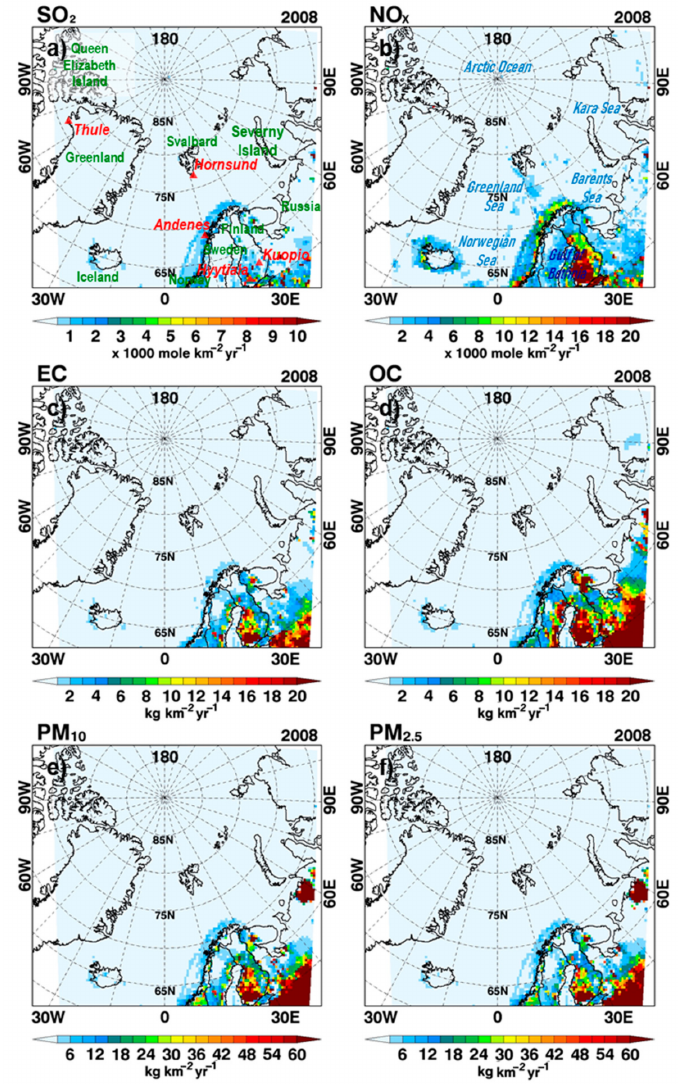
Figure 1. Bottom–up emissions of ( a ) SO 2 , ( b ) NO x , ( c ) EC, ( d ) OC, ( e ) PM 10 , and ( f ) PM 2.5 for the CMAQ simulations over the Arctic. The red triangles ( (cid:78) ) in the panel of ( a ) represent the locations of five AERONET stations of Thule, Hornsund, Andenes, Hyytiala, and